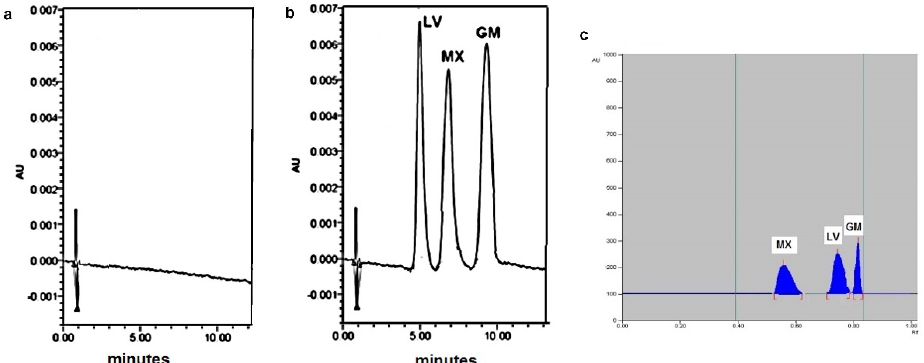
Figure 1. ( a ) Typical HPLC chromatogram of diluent, ( b ) Typical HPLC chromatogram of 20 µ L injection of prepared mixture containing 5 µ g mL − 1 of each of LV, MX, and GM using the proposed HPLC method; ( c ) HPTLC densitogram of prepared mixture containing 1 µ g /band of MX, 1 µ g/band of LV, and 0.7 µ g/band of GM using the proposed HPTLC method.